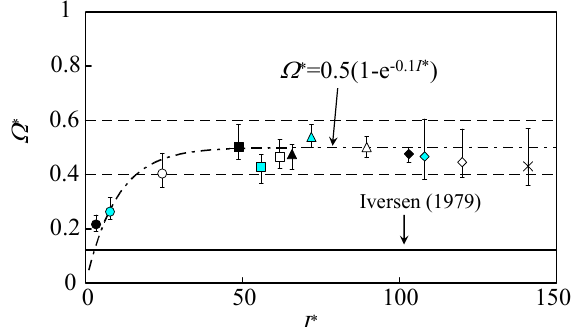
Fig. 11 Reduced rotating rate Ω * of a tumbling plate versus inertia-moment ratio I * , for several values of Reynolds number Re at depth-to-width ratio λ = 0.3, aspect ratio AR = 10, C = 3.86 × 10 2